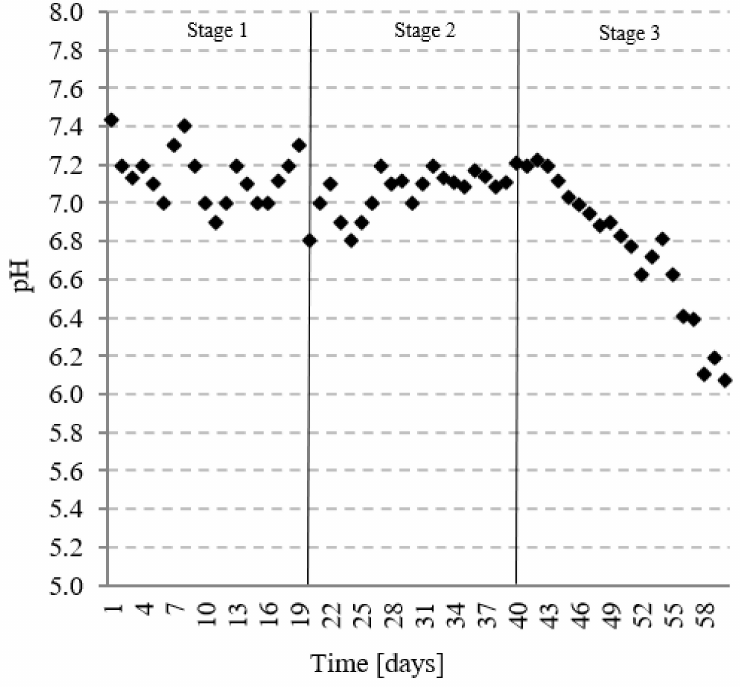
Figure 8. Changes in pH value in the fermentation